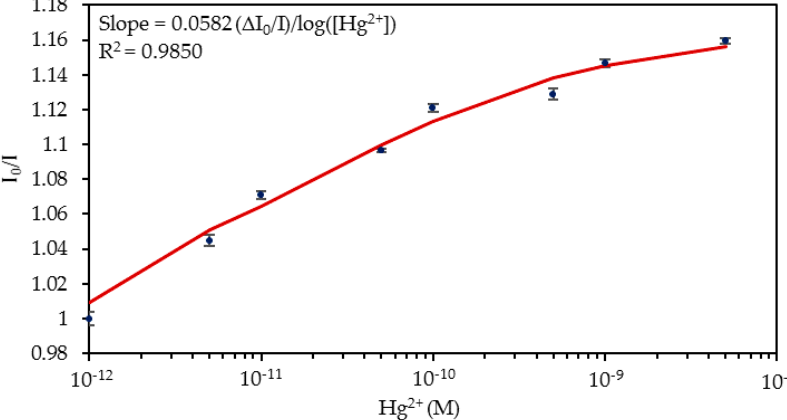
Figure 6. I 0 /I ratio for the different Hg 2+ concentrations in PBS solution. The horizontal axis is shown in logarithmic scale.